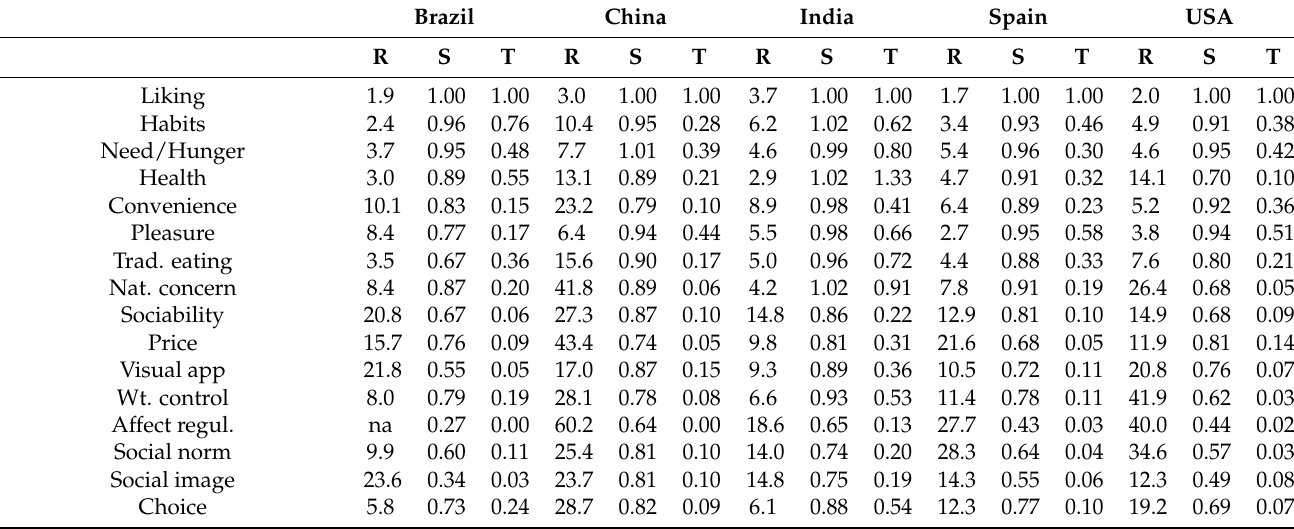
Table A7. Ratios of RATING “apply” responses to RATA “apply” responses (R) and standard indices of importance for RATING (S) and RATA (T) “apply” responses for each motivation construct to the liking motivation construct for protein-rich foods in all five countries.